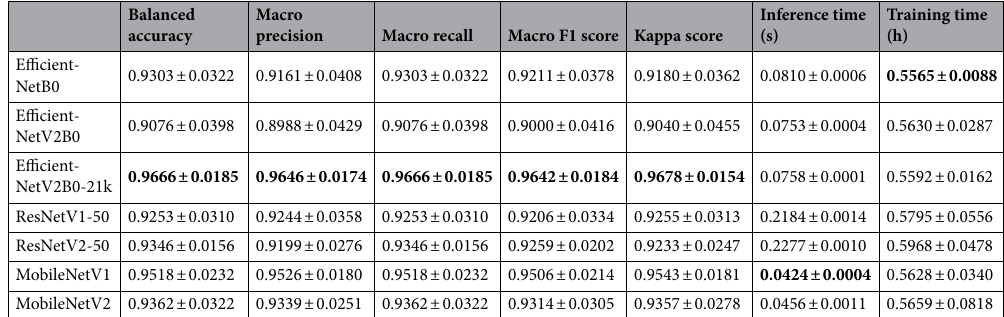
Table 7. This table summarises the results acquired from the fivefold stratified CV. Each performance metric was reported in average (± standard deviation) form. The bold values represent the best score in each category. The best overall performing model was found to be EfficientNetV2-B0-21k, and the fastest CNN model was